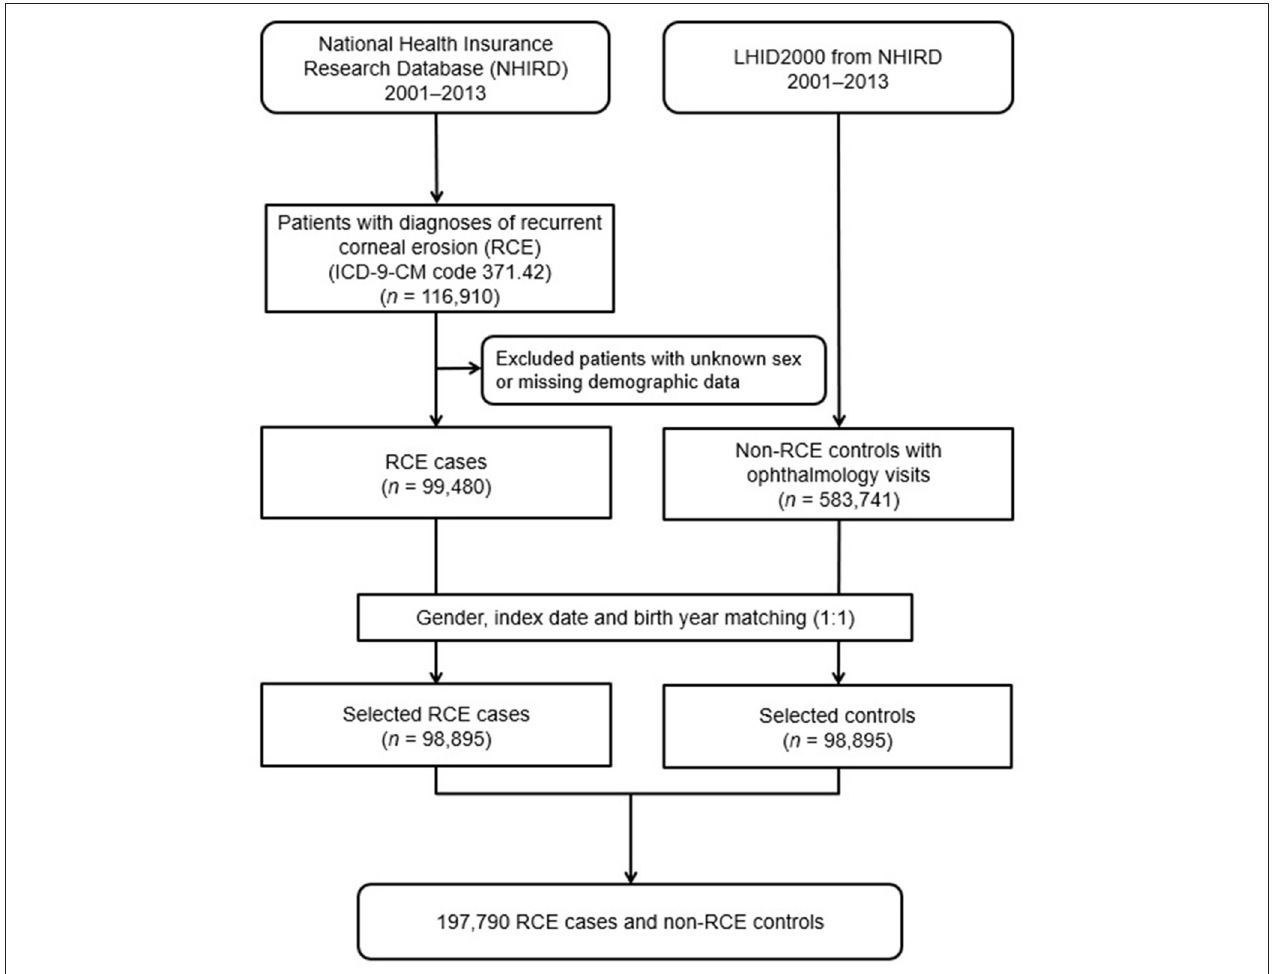
FIGURE 1 | Flowchart demonstrating the enrolment of patients with RCE and the control